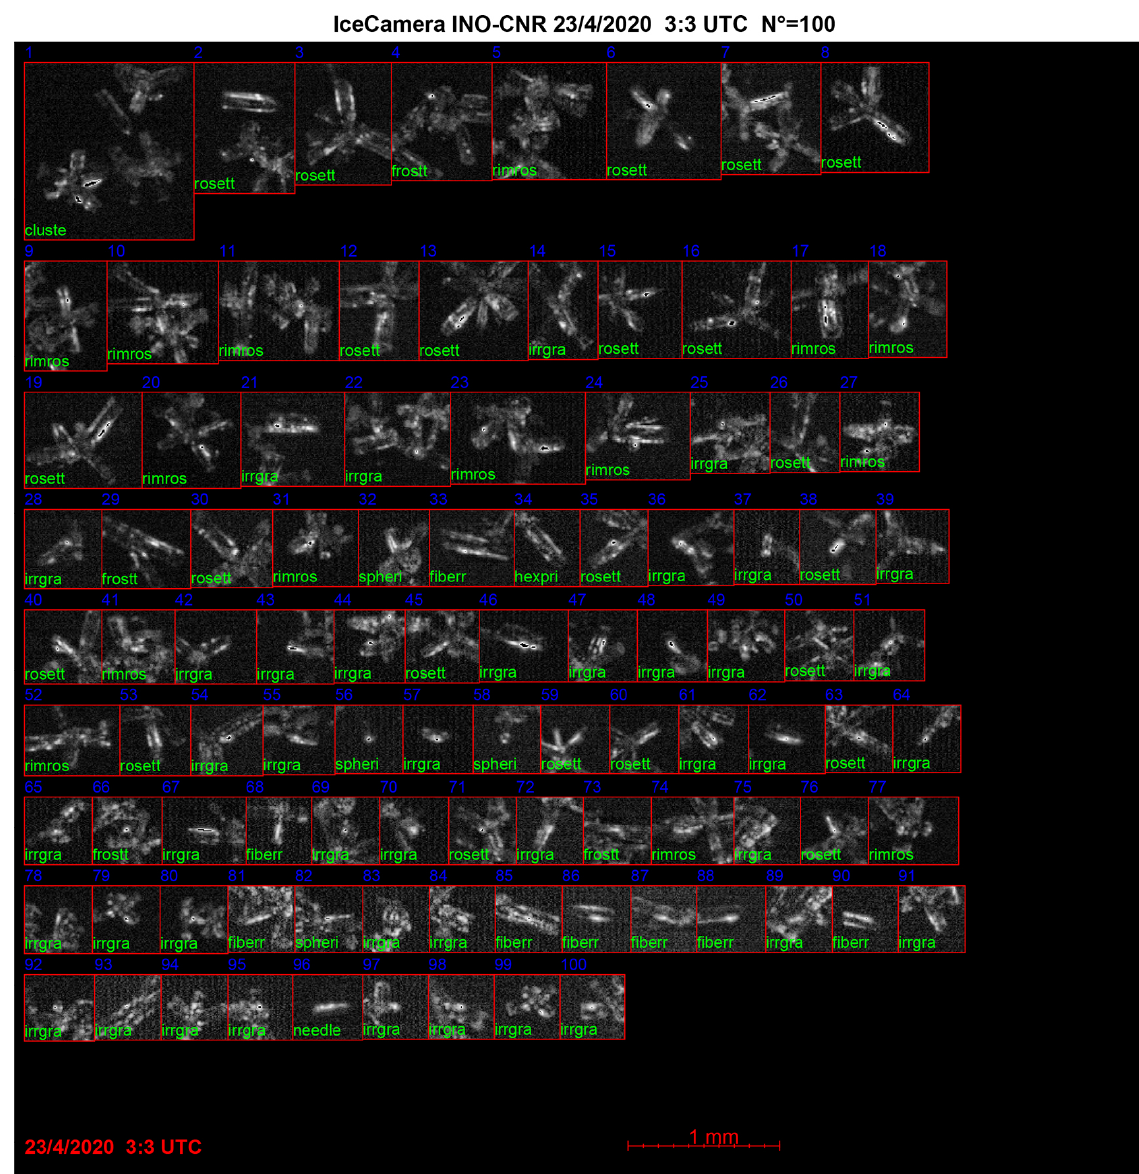
Figure 26. As for Fig. 20, but for the day of 23 April 2020 at 03:03UTC. At this time, crystals aggregates and bullet rosettes are